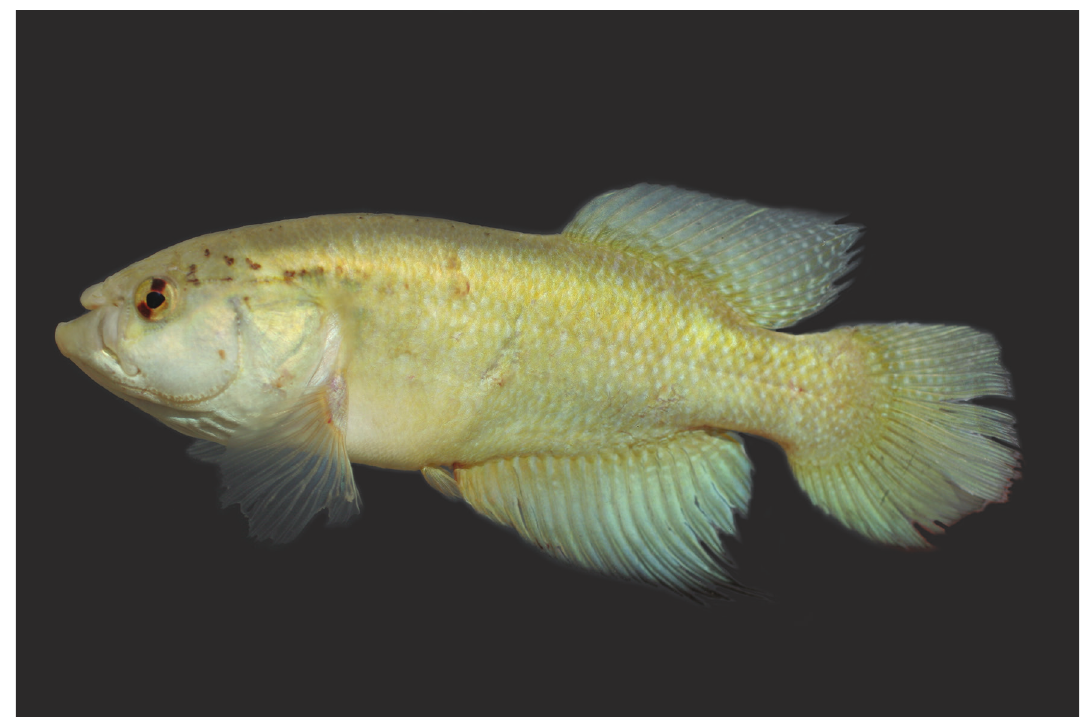
Figure 3. Cynolebias gorutuba sp. n., live holotype, UFRJ 6789, male, 88.8 mm SL. Photograph by W.J.E.M. Costa.